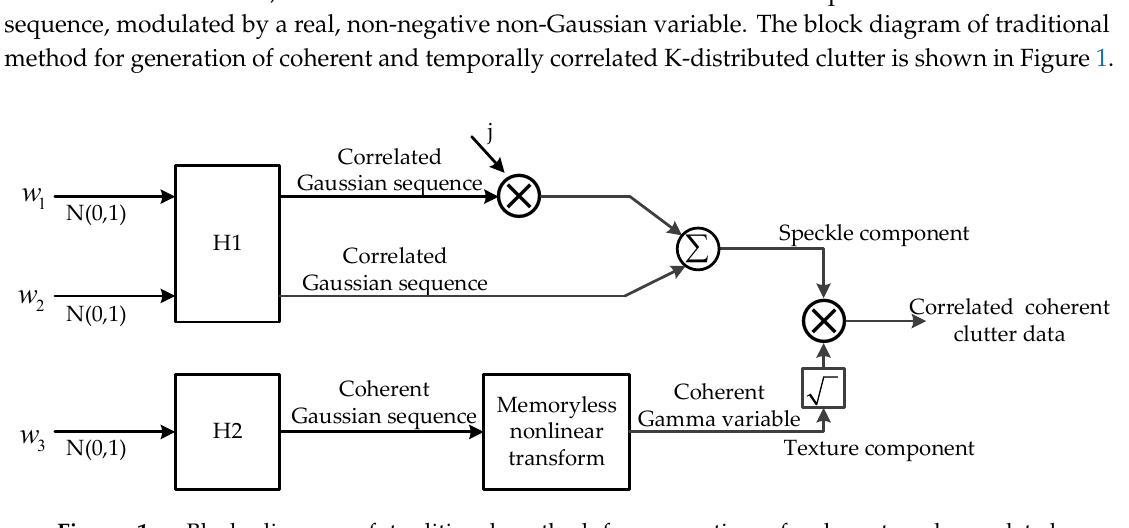
Figure 1. Block diagram of traditional method for generation of coherent and correlated K-distributed clutter.